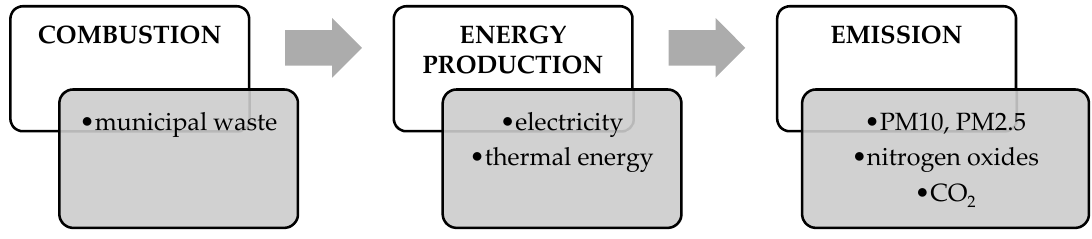
Figure 1. Chronology of processes occurring during the thermal transformation of